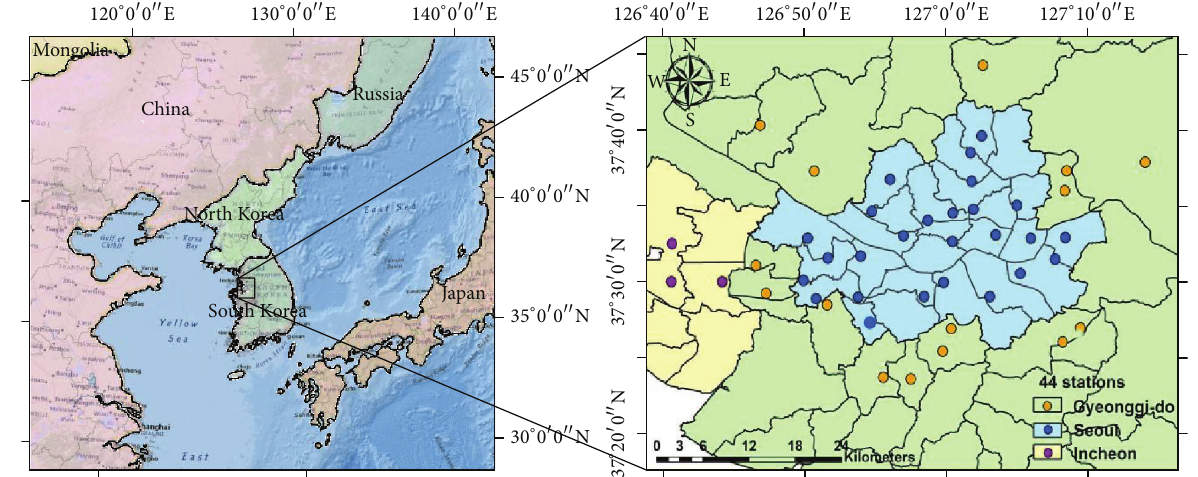
Figure 1: Base map of the study area, showing 44 air pollution monitoring